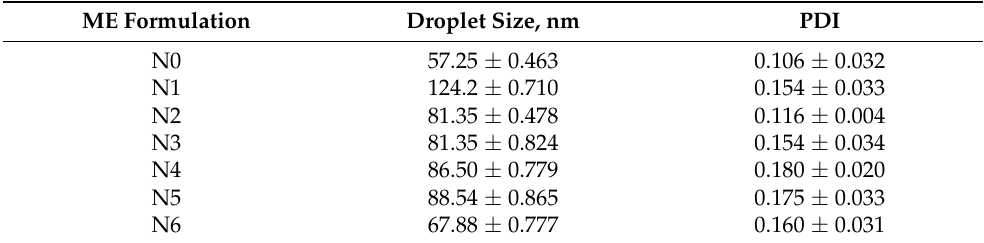
Table 3. Size and polydispersity index (PDI) of microemulsions containing RJ.